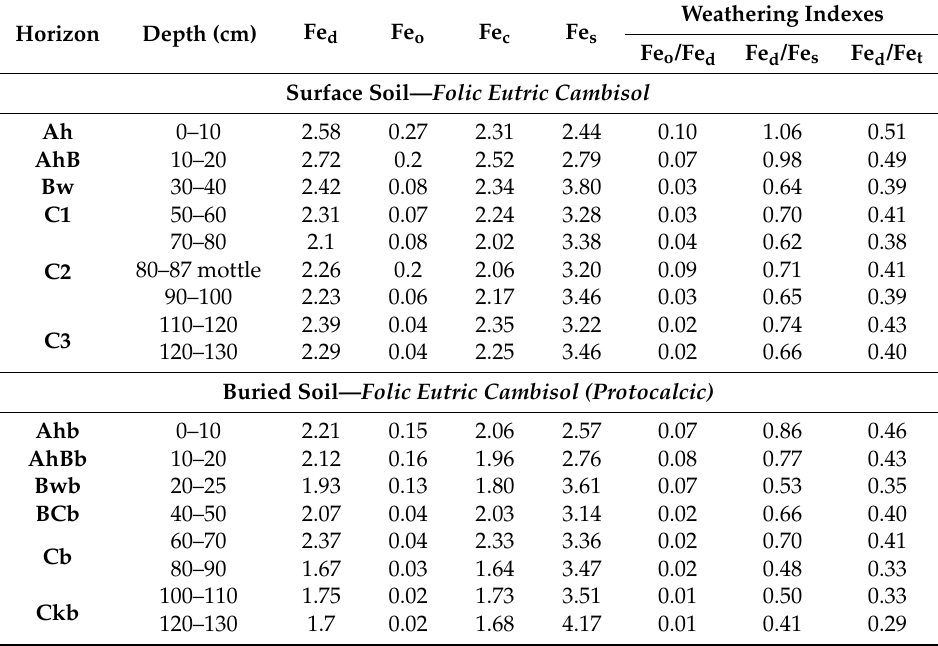
Table 6. Iron (FeO) fractions in the surface and buried soils,